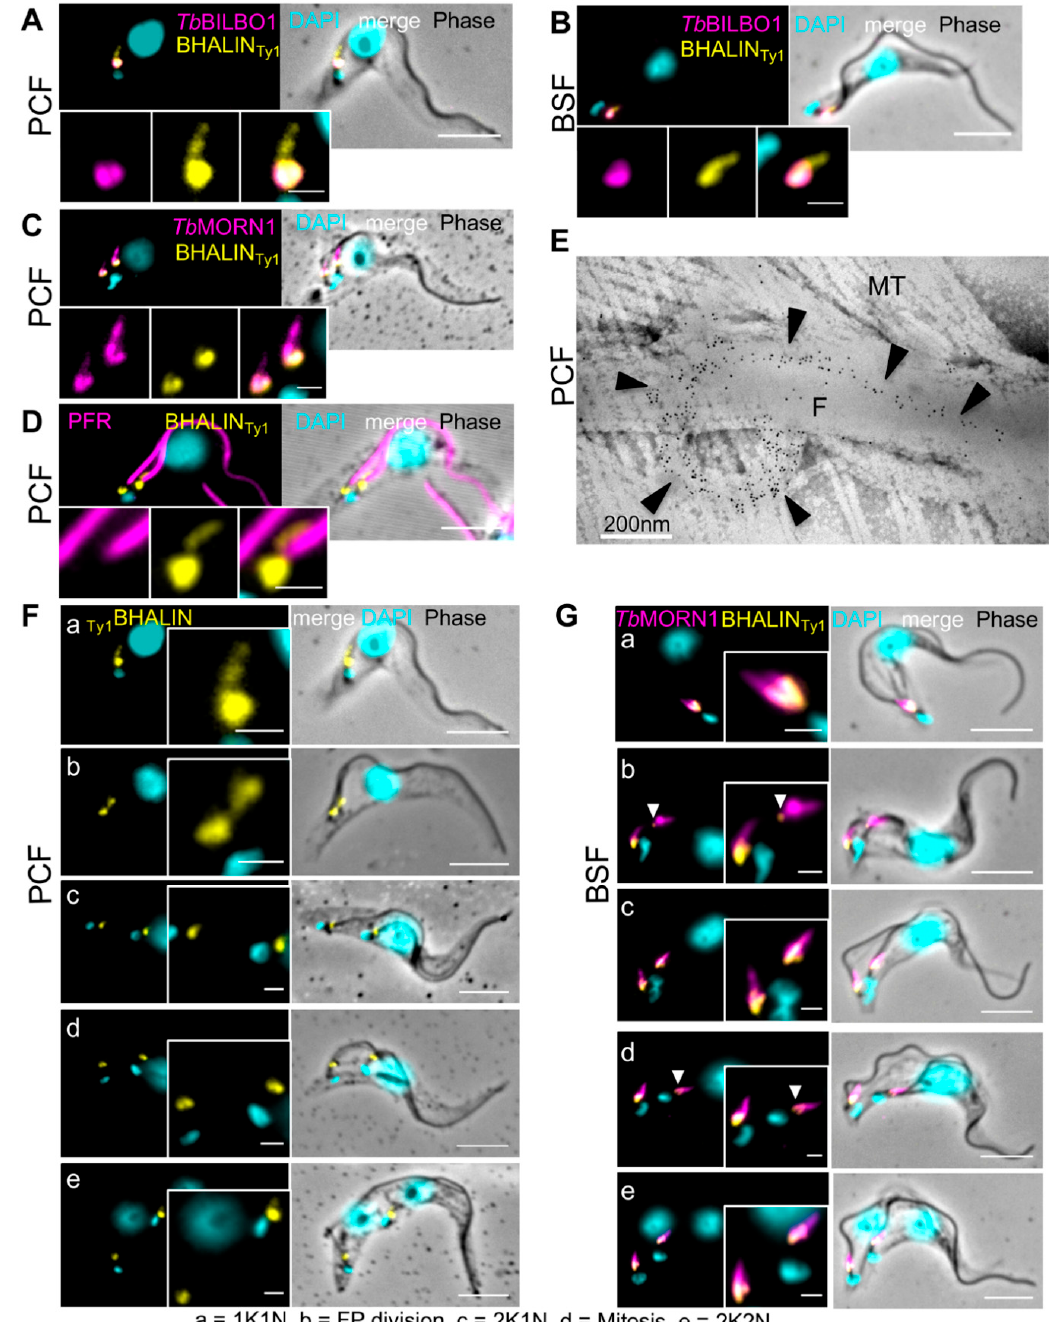
Figure 2. BHALIN forms a hook-shaped structure at the hook complex. Immunofluorescence assays of detergent-extracted trypanosomes. Partial co-localisation of Tb BILBO1 (magenta) and BHALIN (yellow) was seen in ( A ) PCF and ( B ) BSF. In both cases Ty1-tagged BHALIN exhibited a hook-shaped structure with the head at the FPC and the shank extending distally. ( C ) PCF showing co-localisation of Tb MORN1 (magenta) and BHALIN (yellow); the shank of the hook could be seen extending distally along the flagellum. ( D ) PCF showing co-localisation of PFR (magenta) and BHALIN (yellow); the shank of the hook is seen extending distally along the flagellum next to the PFR. ( E ) Immuno-electron micrograph of PCF flagellum with anti-Ty1 gold labelling of BHALIN; The black arrowheads indicate the regular positioning of the gold beads on the HC. F = flagellum, MT = microtubules. ( F ) PCF showing labelling of BHALIN (yellow) through the cell cycle. ( G ) BSF showing co-localisation of Tb MORN1 (magenta) and BHALIN (yellow) through the cell cycle. White arrowheads in G indicate the sometimes vestigial BHALIN signal on the old HC; K = kinetoplast, N = nucleus. Scale bar = 5 µ m, inset = 1 µ